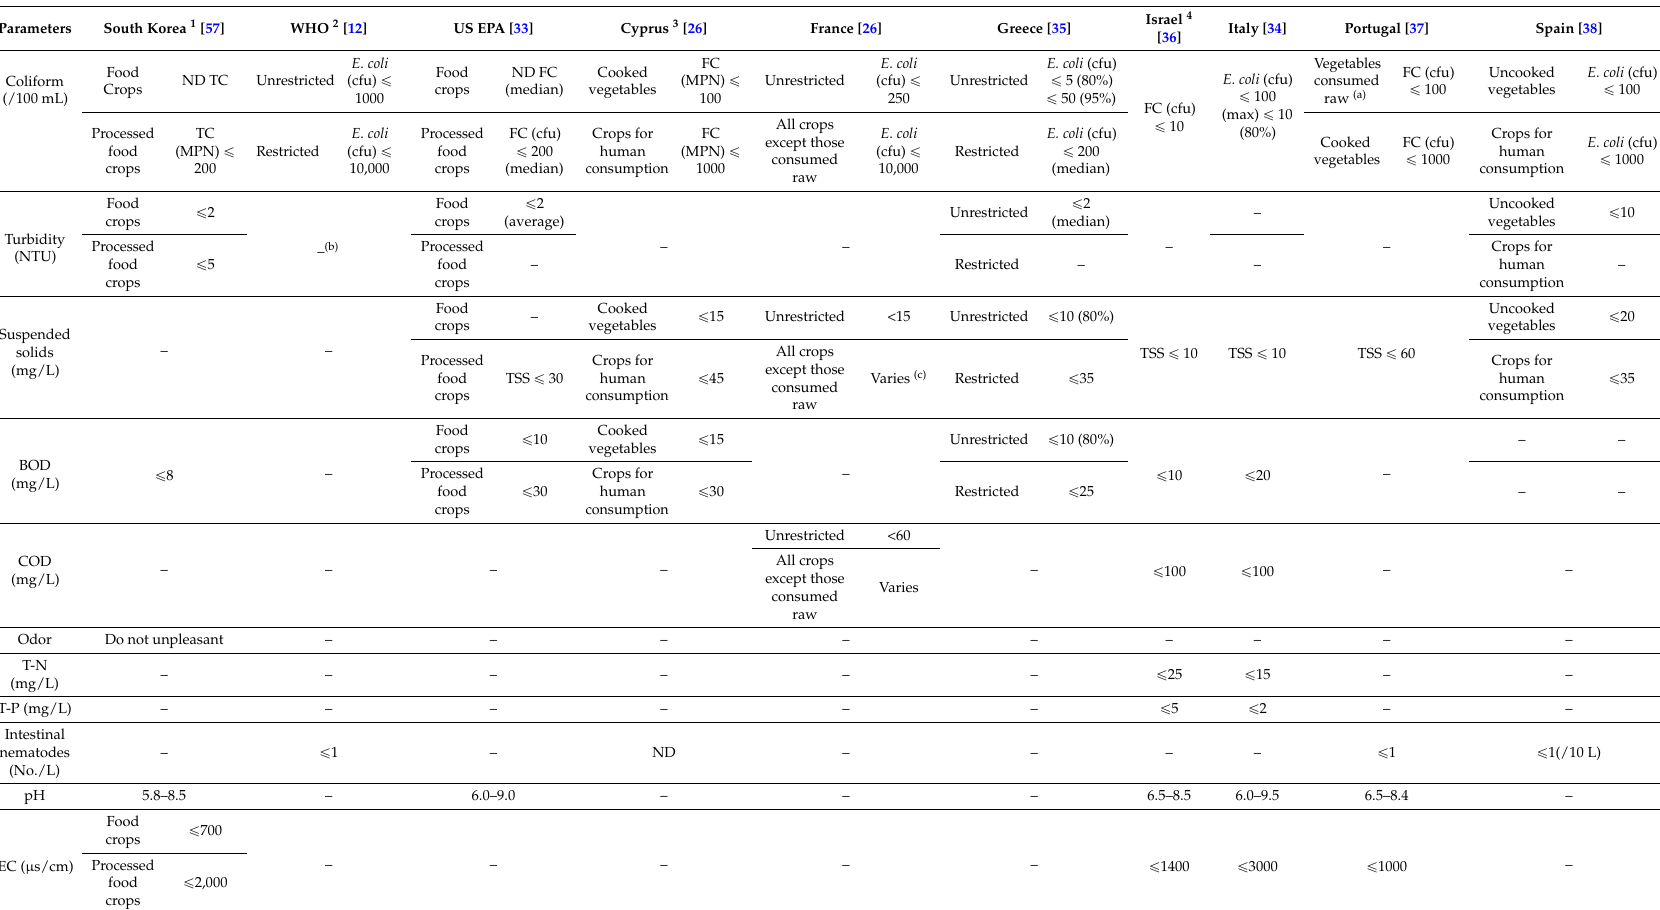
Table 2. Irrigation water quality guidelines and standards for wastewater reuse in